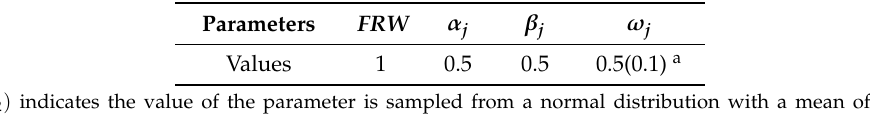
Table 3. The Values of Model Parameters.